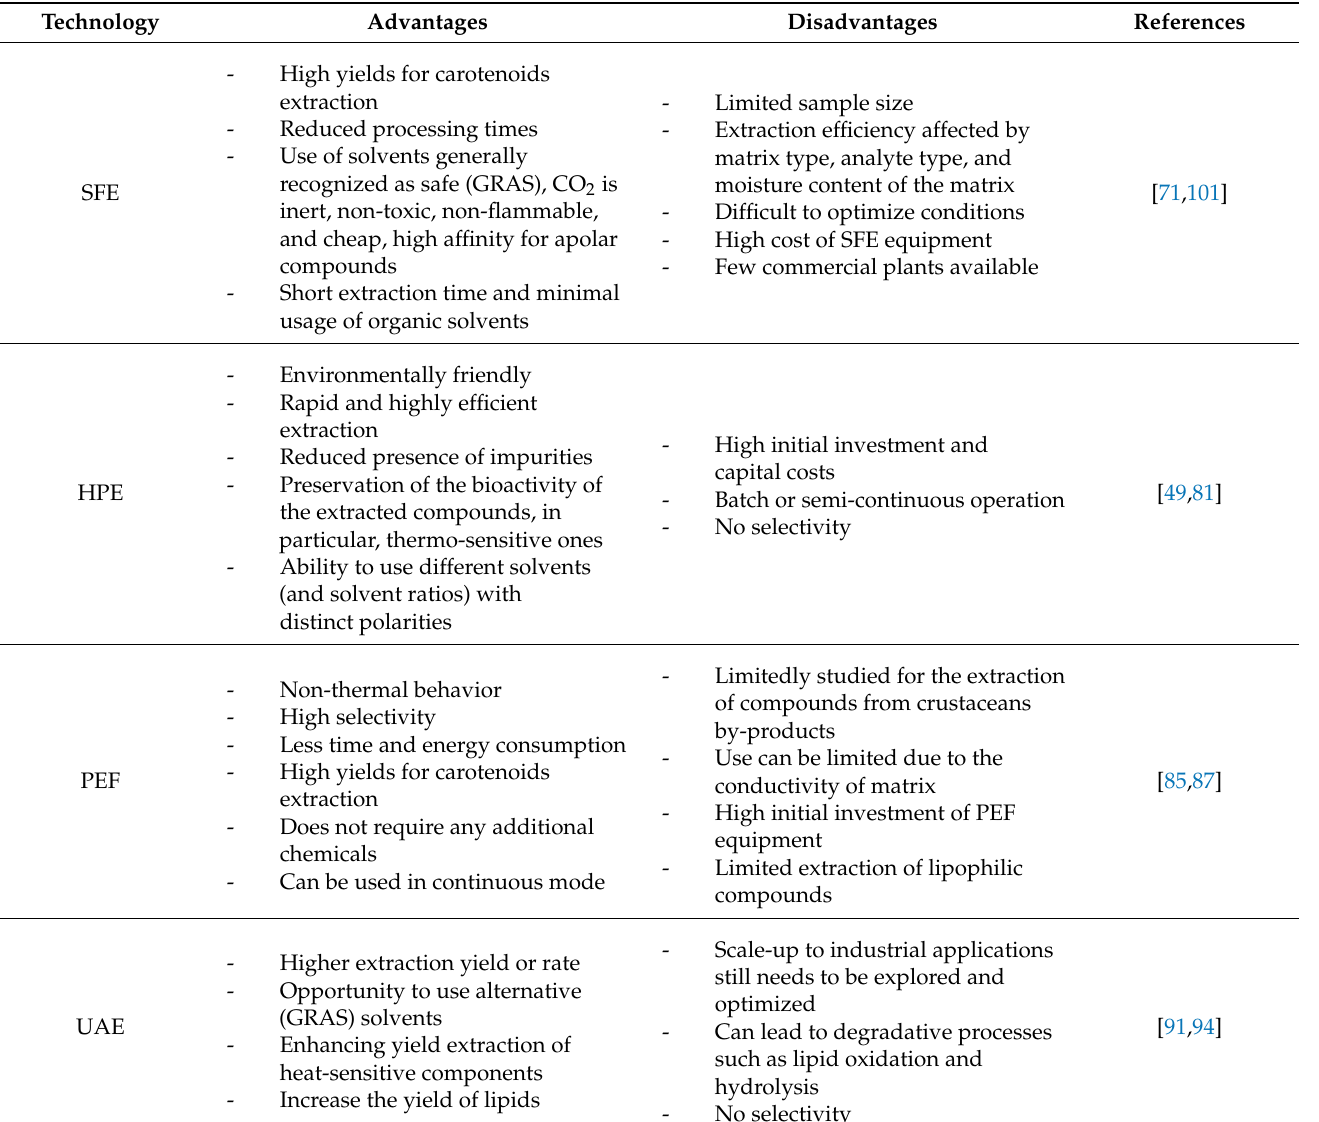
Table 4. Advantages and disadvantages of the considered technologies in comparison with traditional ones. Technology